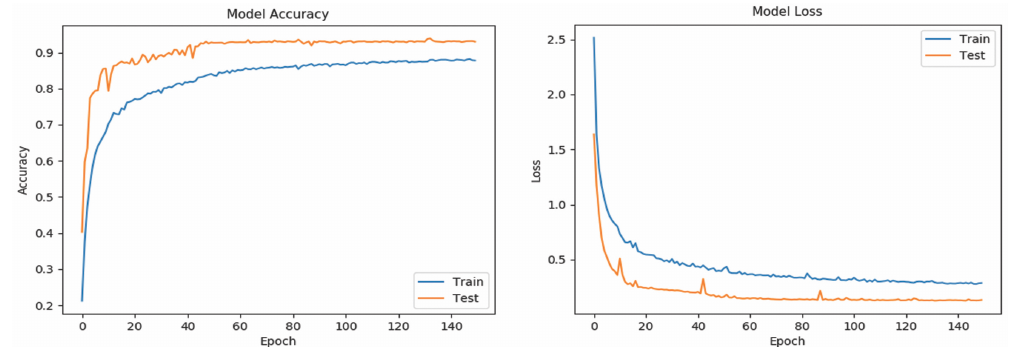
Figure 8. Performance of trained RNN 5 with high DR value, evaluated with mean accuracy rate ( left ) and loss function ( right